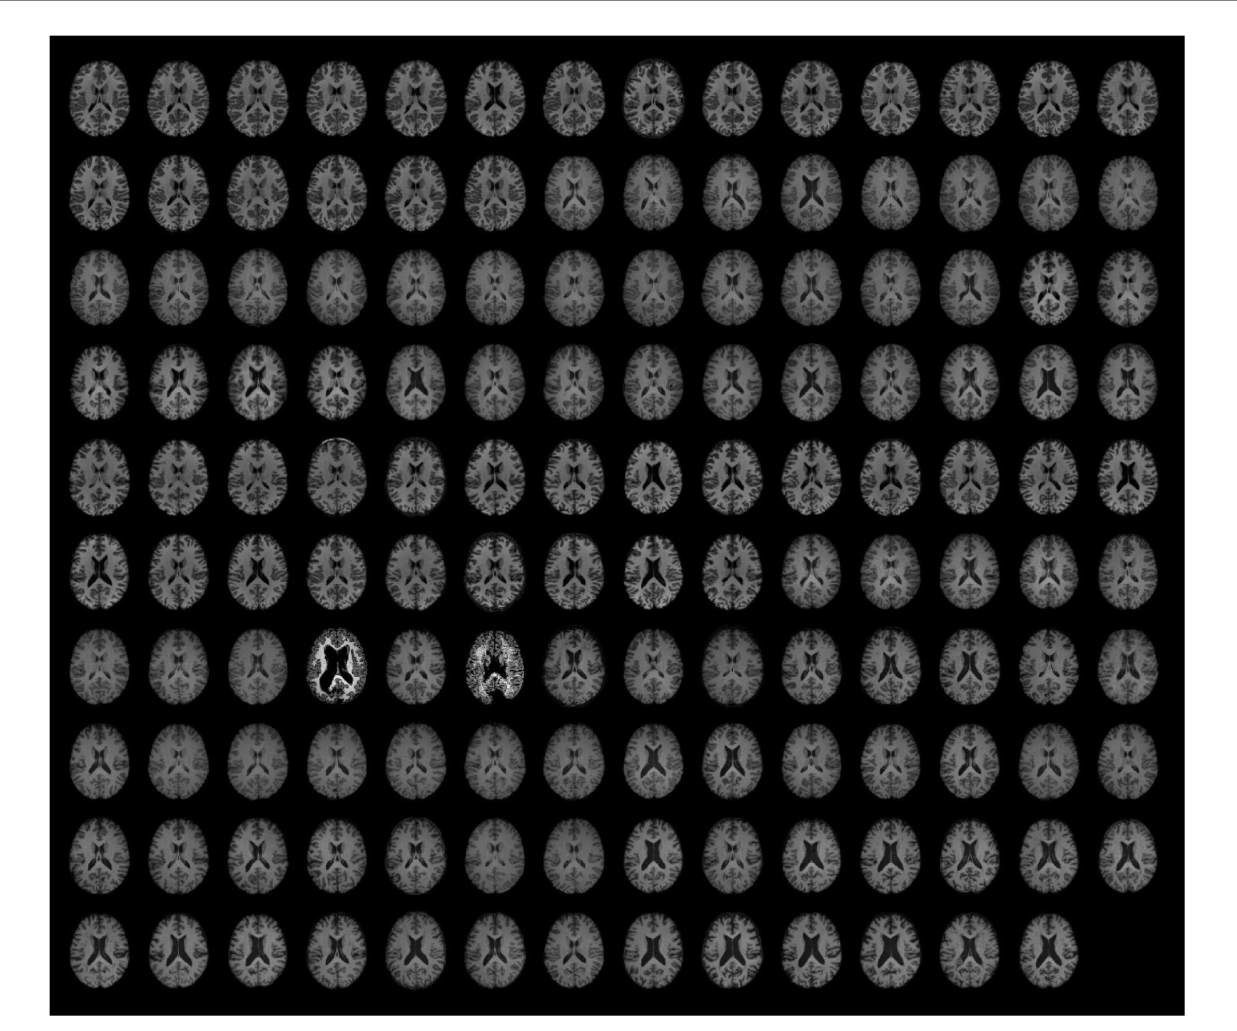
FIGURE 6 Preprocessed anatomical data. The same axial slice (MNI z = 18) of the fully preprocessed anatomical images is rendered for each participant ( n = 139). For visualization purposes only, the BOLD signal intensity was scaled by the average value within each